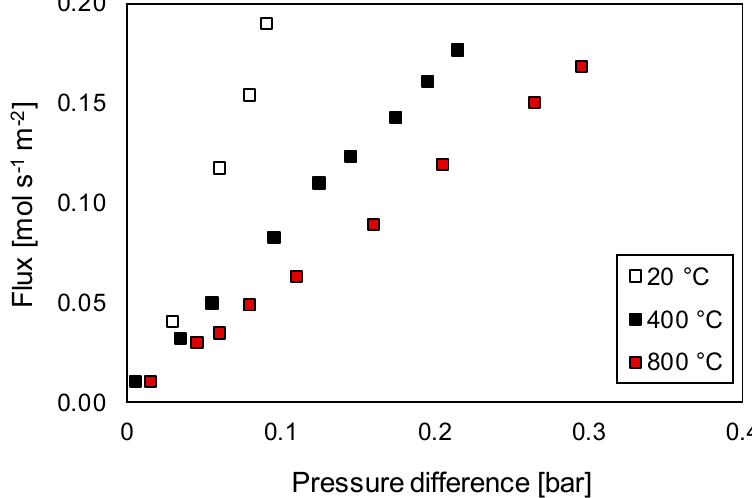
Figure A1. Flux of the symmetric MgO porous membrane plotted against the retentate–permeate pressure difference when different gases were fed in the retentate side. The experiments were carried out at 800 °C with a permeate pressure of 2 bar. The membrane used was the one described in Table 4.